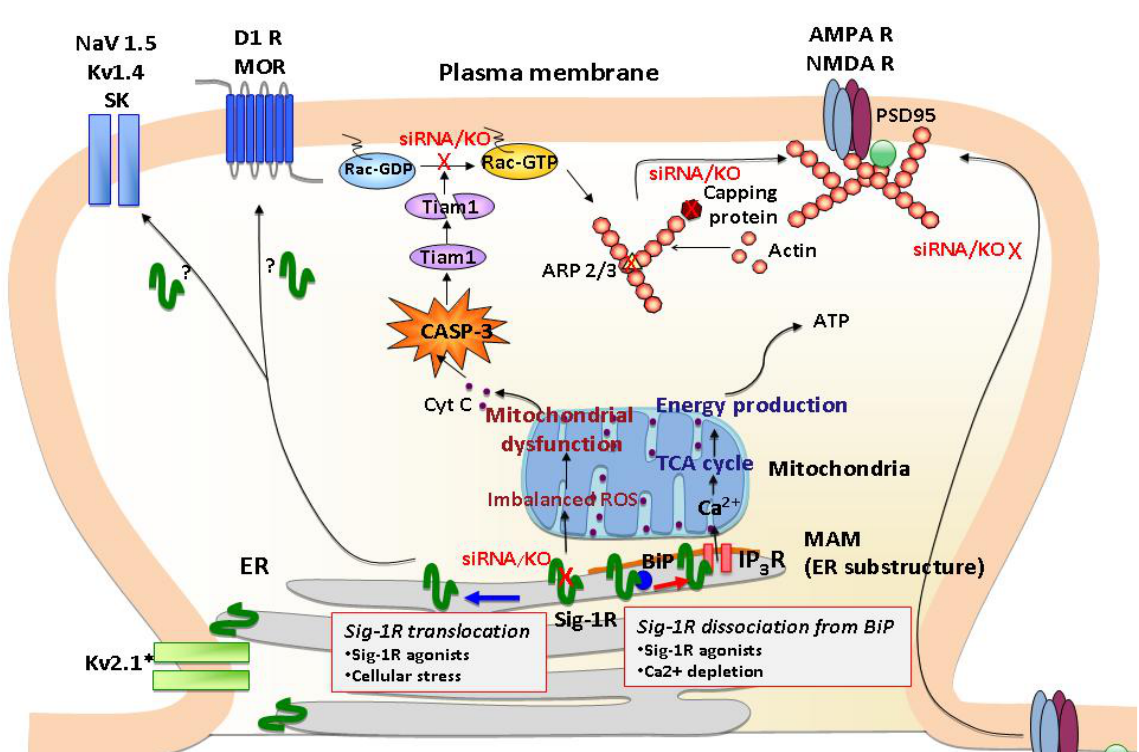
Figure 1. Potential synaptic actions of σ